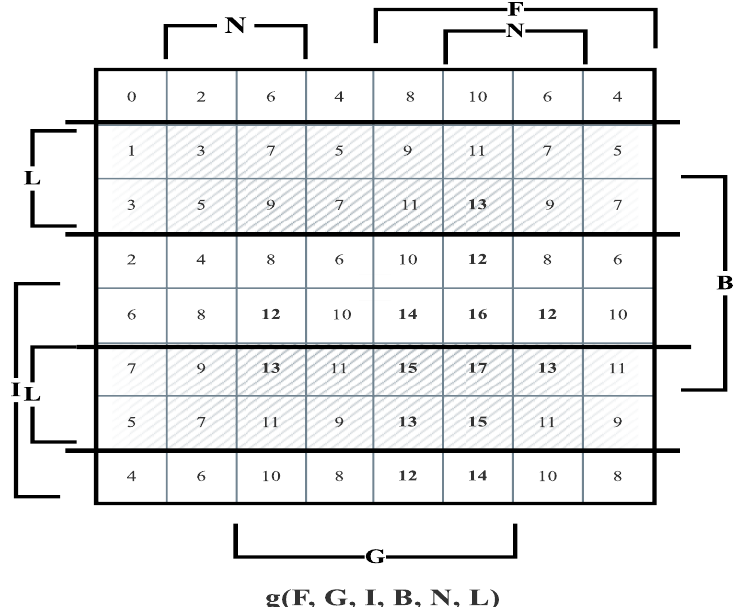
Fig. 7. A pseudo-switching function representing the sum of weighted votes, showing that there is no primitive winning coalition of which L is a member, and her defection is